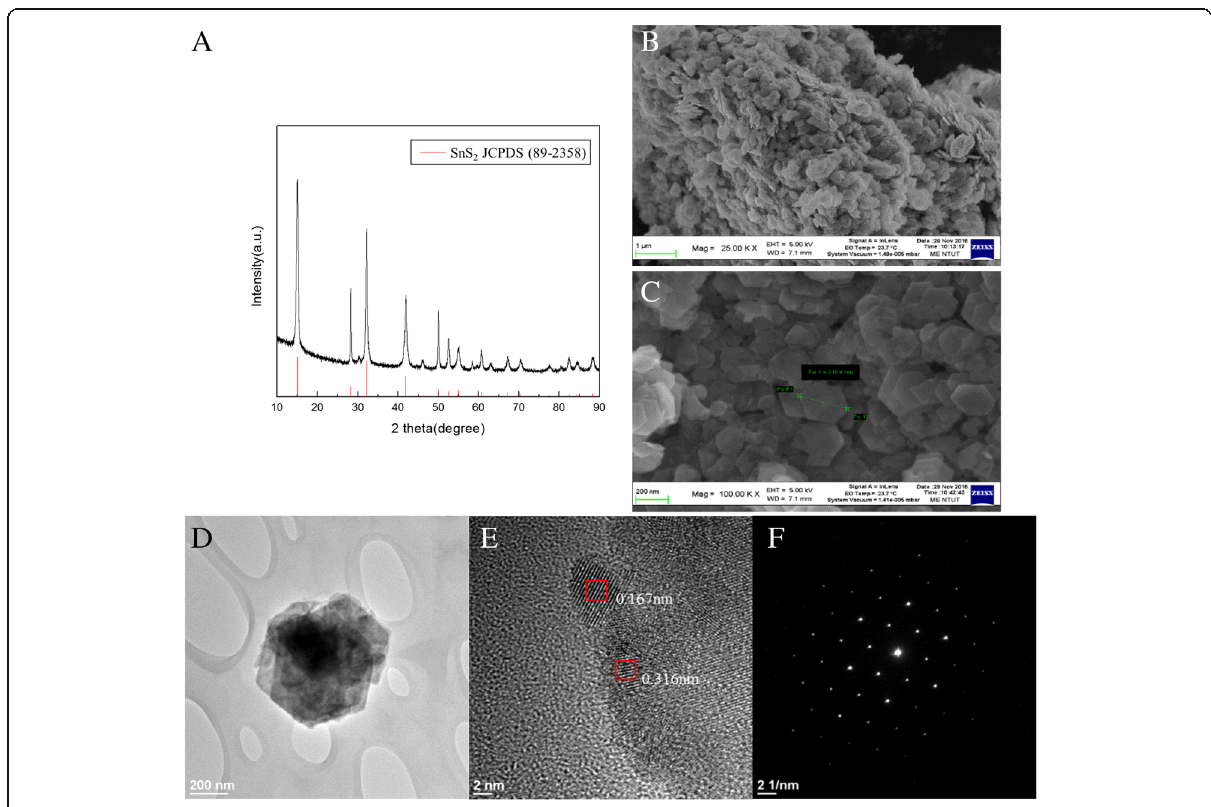
Fig. 2 a XRD pattern of SnS 2 . FE-SEM images of SnS 2 nanoflakes were taken at magnifications of ( b ) × 250,000 and ( c ) × 100,000. d FEG-TEM images of SnS 2 nanoflakes. e Cross-sectional FEG-TEM of SnS 2 nanoflakes and zoomed-in FEG-TEM image. f SAED image of SnS 2